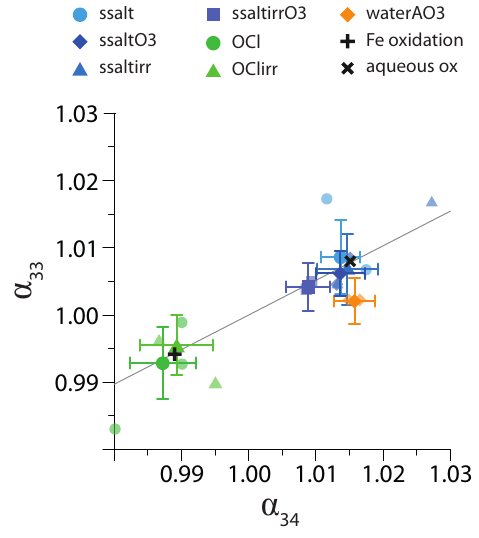
Fig. 5. Fractionation factors for the uptake and oxidation of SO 2 by droplets of pure water, sea salt aerosol and NaOCl aerosol (abbrevi- ations are defined in Table 1). Pale points are the individual exper- imental runs for each set of conditions, while dark points show the average with 1 σ error bars. The grey line represents mass depen- dent fractionation and the black crosses show previously measured fractionation factors from Harris et al.